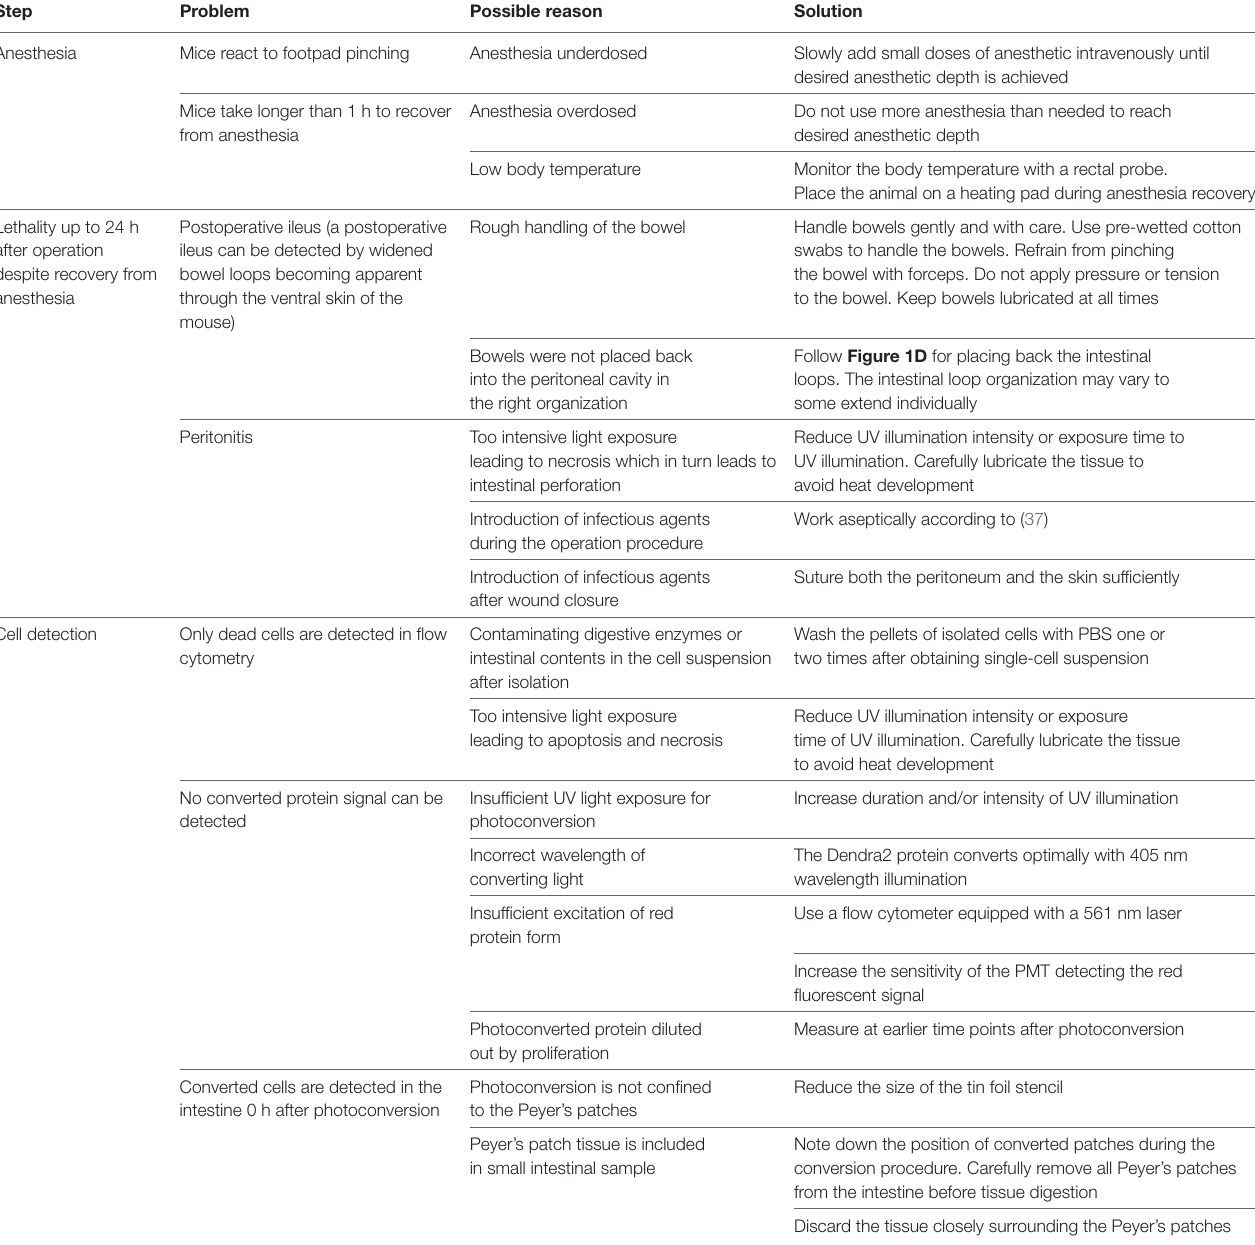
tAblE 2 | Troubleshooting